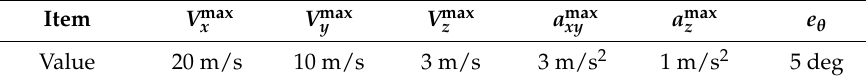
Table 2. Constraints of helicopter performance and landing task.